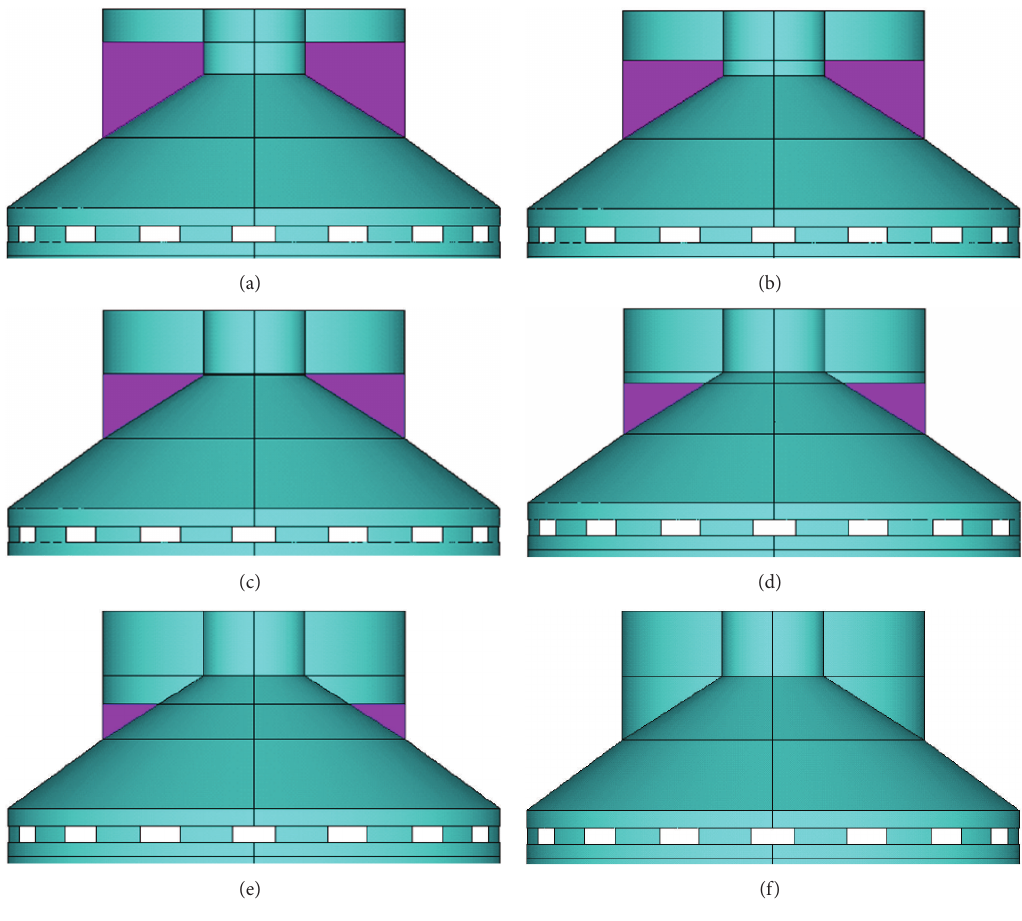
Figure 3: Water levels ranged from Case I to Case